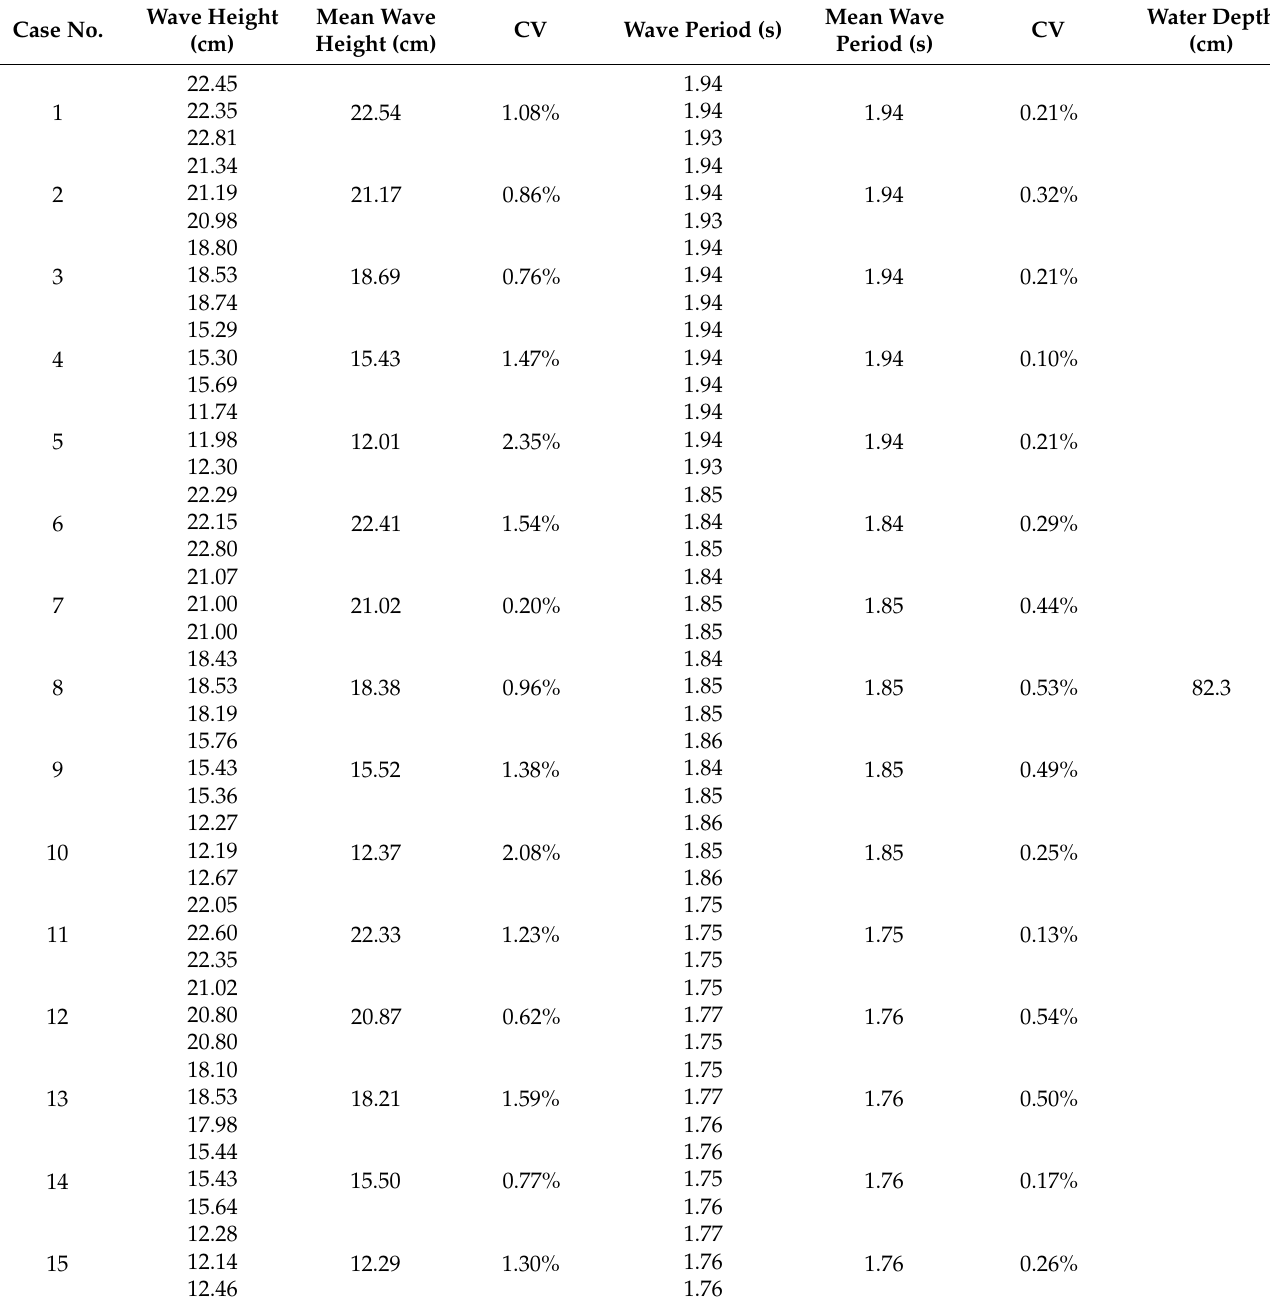
Table 1. Wave conditions used in